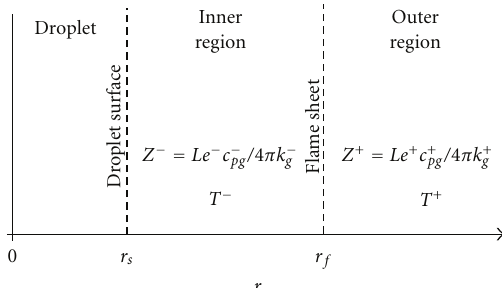
Figure 1: Separation of inner region and outer region species